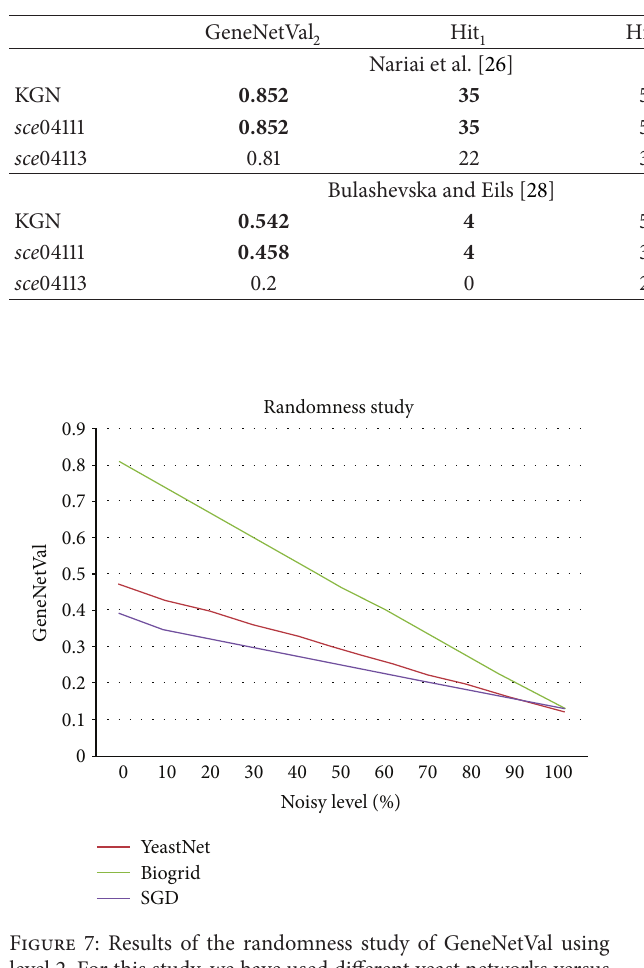
Table 2: Most representative 𝐿𝑒 V 𝑒𝑙 2 results found using our method assessing some yeast cell cycle networks. The results from GeneNetVal and the Hits levels 1 and 2 obtained from the evaluation are shown. Note that all similarities found with the KGN are also found for the cell cycle pathways network as expected.